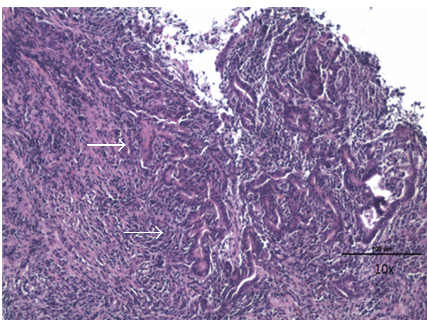
Figure 2: Histopathology of the large gastric mass. Note the irregular gland formation (arrows) highly suggestive of a di ff use- type gastric adenocarcinoma.